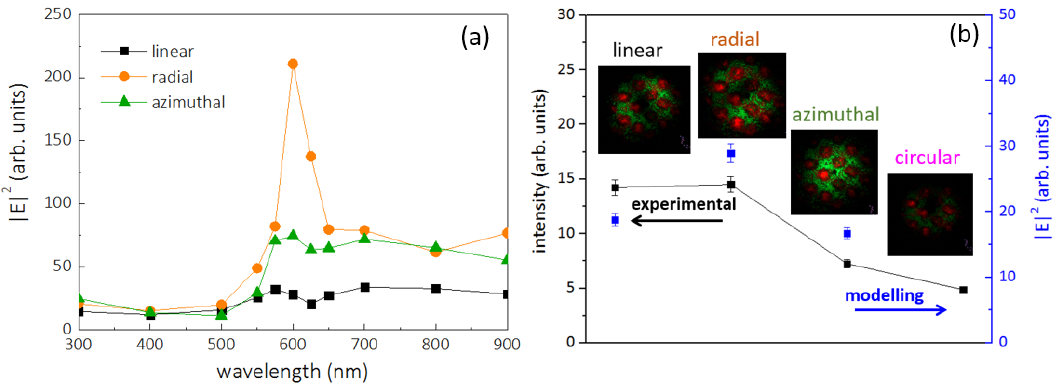
Figure 7. ( a ) Calculated maximal value of |E| 2 for the different polarizations depending on the wavelength. ( b ) Dynamics of the PL intensity at 625 nm versus different laser polarizations (left axis) and the corresponding simulation results of |E| 2 measured at 515 nm.